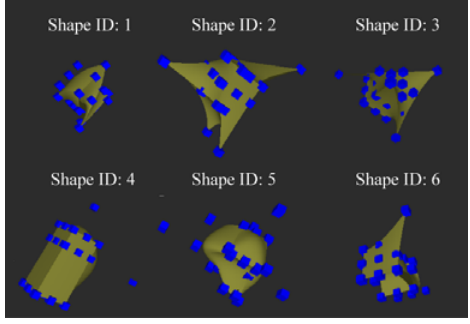
Figure 3. Geon objects as target and manipulator objects.